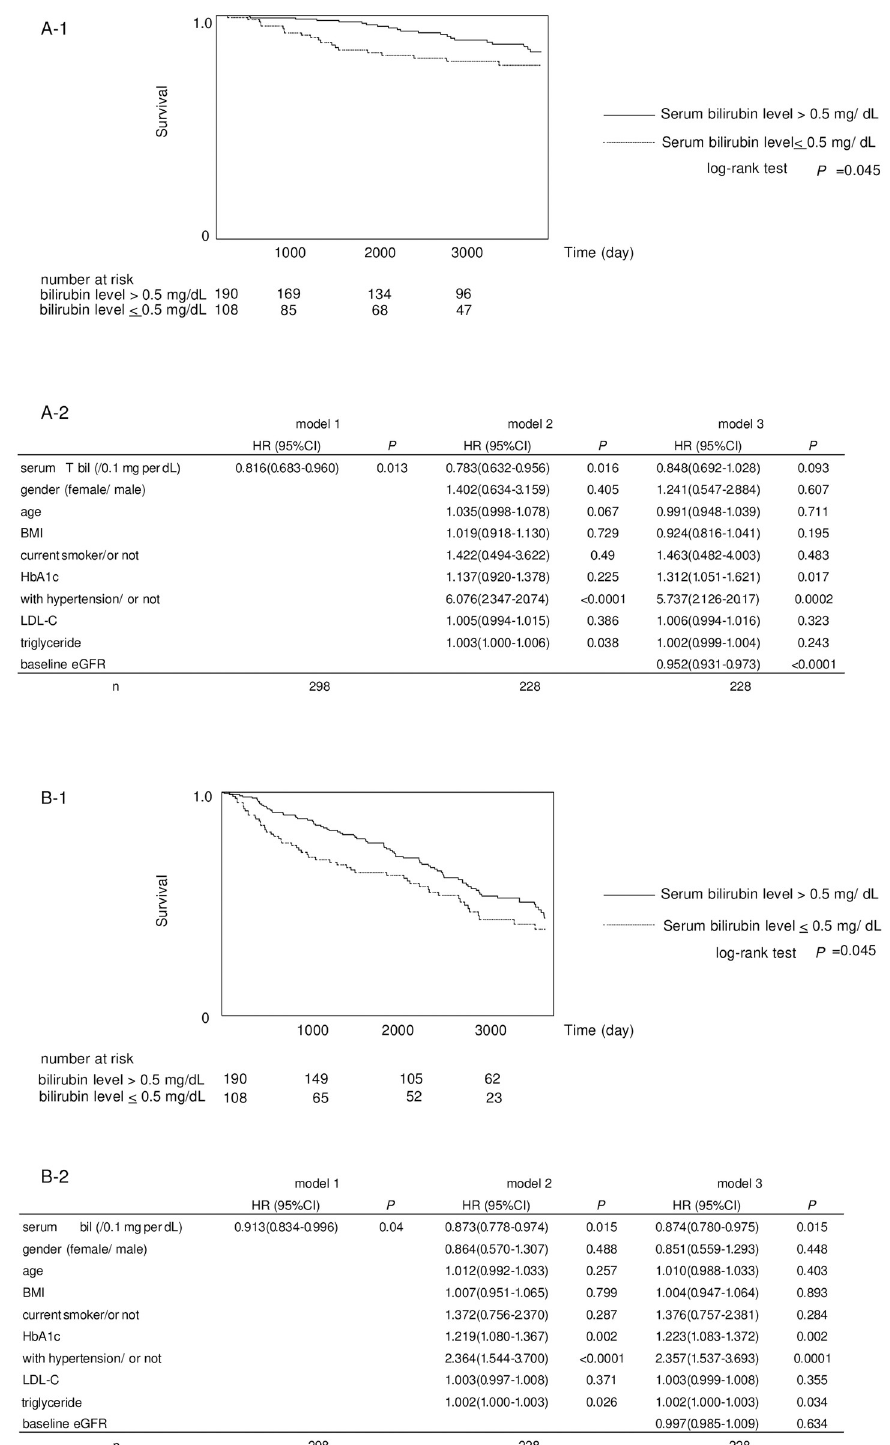
Fig 2. Comparison in renal endpoints between low bilirubin group ( � 0.5 mg/dL) and high bilirubin group ( > 0.5 mg/dL) by Kaplan-Meier method and Cox hazard regression models showing the independence of baseline serum total bilirubin levels to predict renal endpoints. (a) The cumulative incidence of composite endpoint (end-stage kidney disease or doubling of serum creatinine) levels by Kaplan-Meier method are shown at upper panel. Cox hazards regression model was used to analyze the independence of baseline serum total bilirubin levels to predict the composite